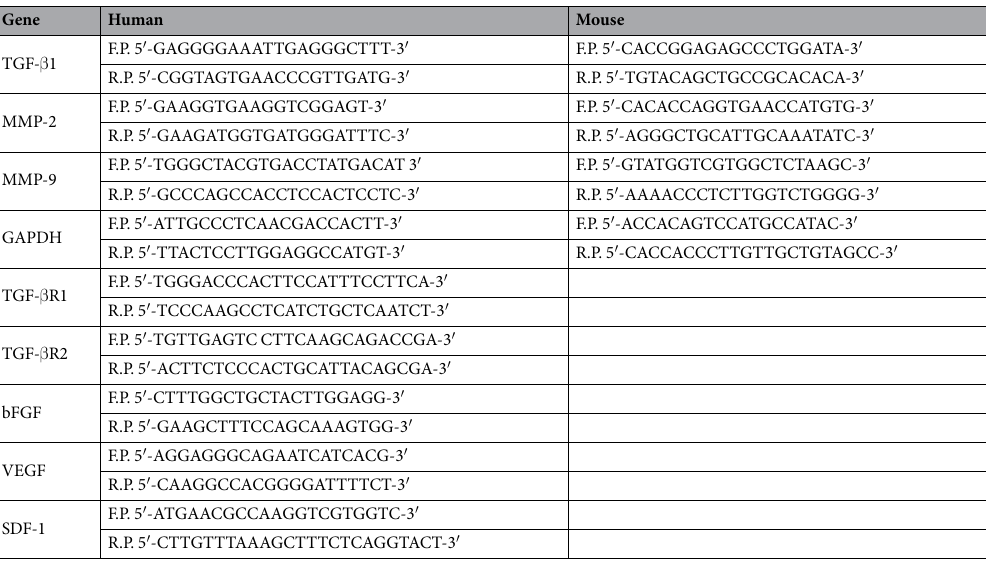
Table 1. Primers used in quantitiative real-time